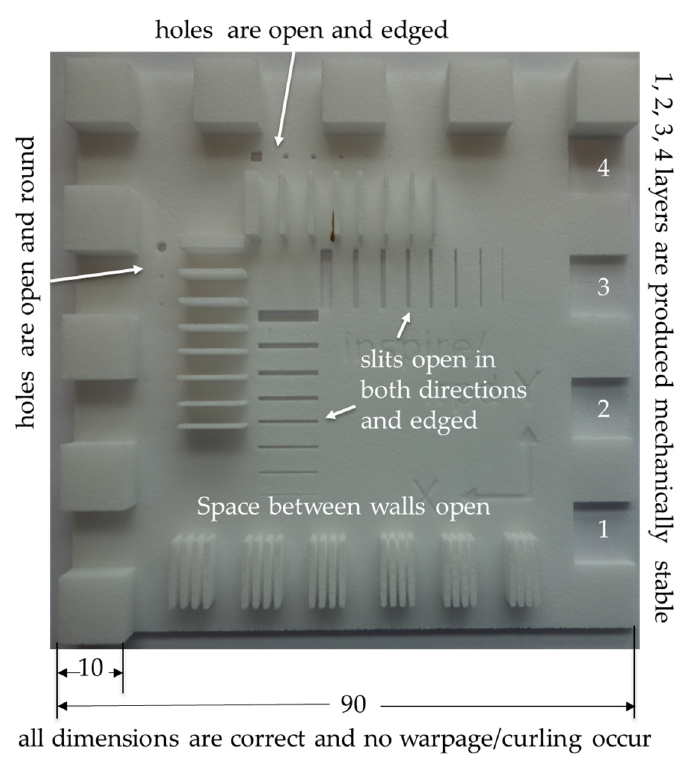
Figure 2. “Benchmark ‐ Part” to optimize the processing parameter towards high ‐ quality parts.